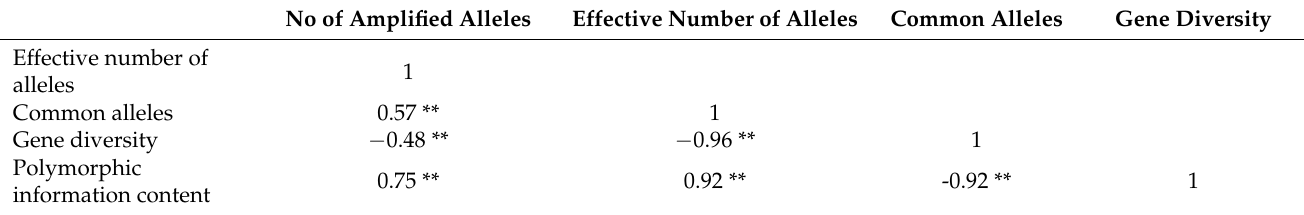
Table 9. The correlation coefficient for polymorphic SSR markers. Effective Number of Alleles Common Alleles Gene